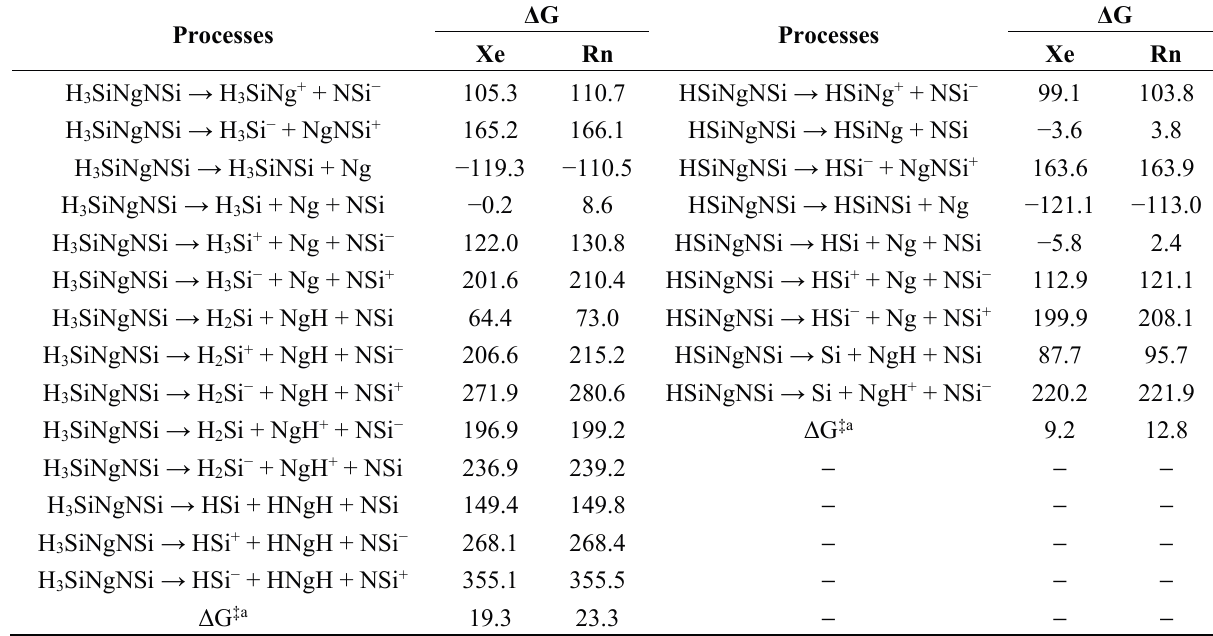
Table 2. Free energy change ( Δ G, kcal/mol) at 298 K for different dissociation channels of H 3 SiNgNSi and HSiNgNSi compounds at the ω B97X-D/def2-QZVPPD level. Δ G Δ G Processes Processes Xe Rn Xe Rn H 3 SiNgNSi → H 3 SiNg + + NSi − 105.3 110.7 HSiNgNSi → HSiNg + + NSi − 99.1 103.8 H 3 SiNgNSi → H 3 Si − + NgNSi + 165.2 166.1 HSiNgNSi → HSiNg + NSi − 3.6 3.8 H 3 SiNgNSi → H 3 SiNSi + Ng − 119.3 − 110.5 HSiNgNSi → HSi − + NgNSi + 163.6 163.9 H 3 SiNgNSi → H 3 Si + Ng + NSi − 0.2 8.6 HSiNgNSi → HSiNSi + Ng − 121.1 − 113.0 122.0 130.8 2.4 201.6 210.4 112.9 121.1 64.4 73.0 199.9 208.1 280.6 199.2 236.9 239.2 149.4 149.8 268.1 268.4